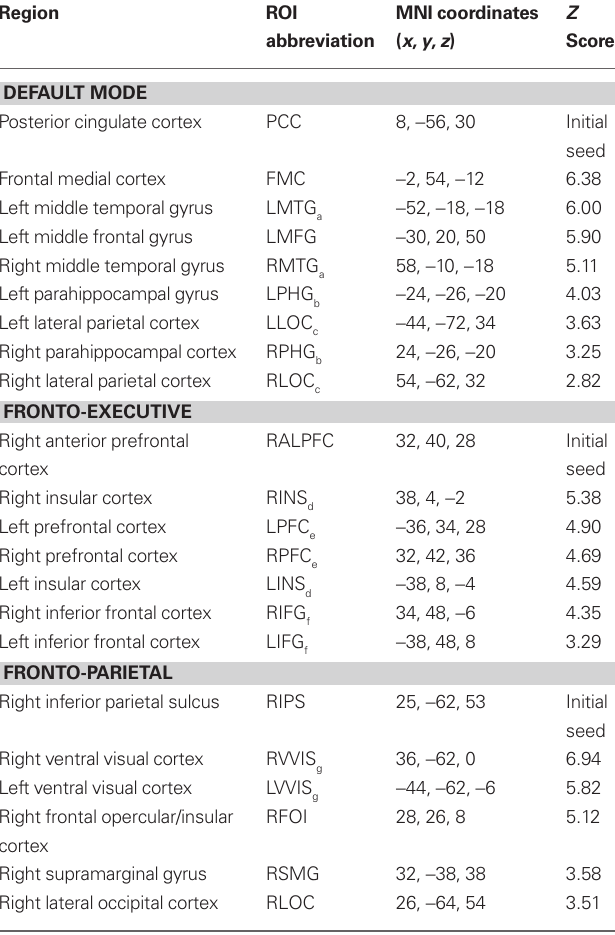
Table 3 | Regions with increased functional connectivity for Young compared to elderly adults in top-down and default mode